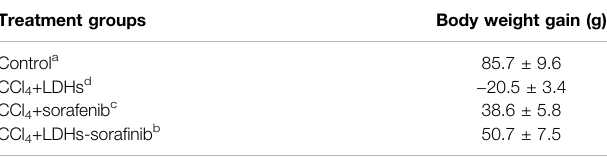
TABLE 1 | Effect of sorafenib and LDHs-SRF on animals ’ body weight after IV administration to fi brotic rats 3 times weekly for 5 weeks. Treatment